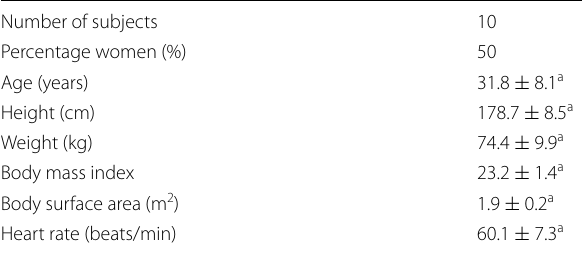
Table 2 Characteristics of the study population